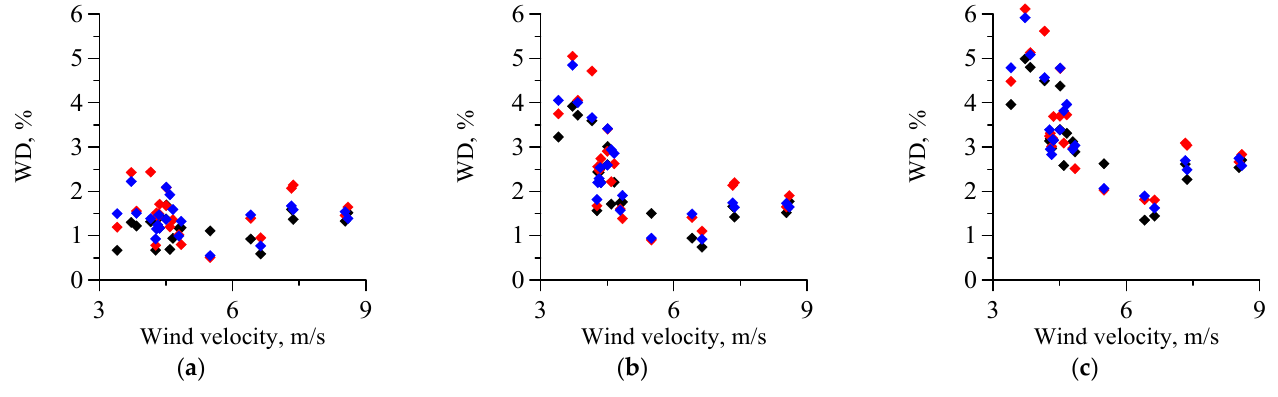
Figure 8. Case study 4.1. WD vs. wind speed (minus the current speed at depths of ( a ) 1 m, ( b ) 4 m, and ( c ) 10 m). Black symbols—S-band, red—C-band, blue—X-band.